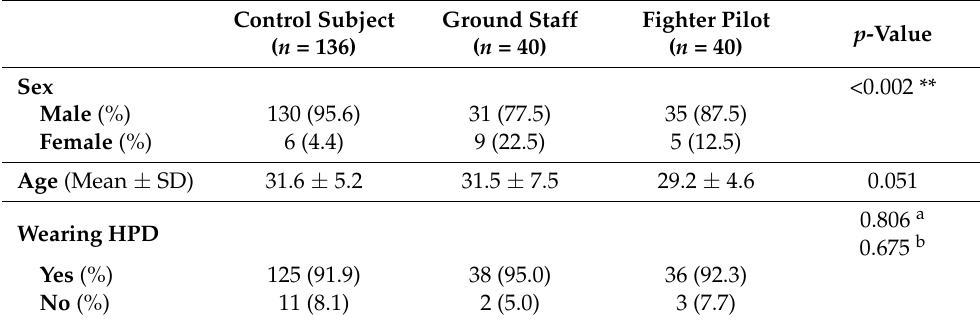
Table 1. The distribution of the subjects by group, sex, age, and habit of wearing a hearing protection device